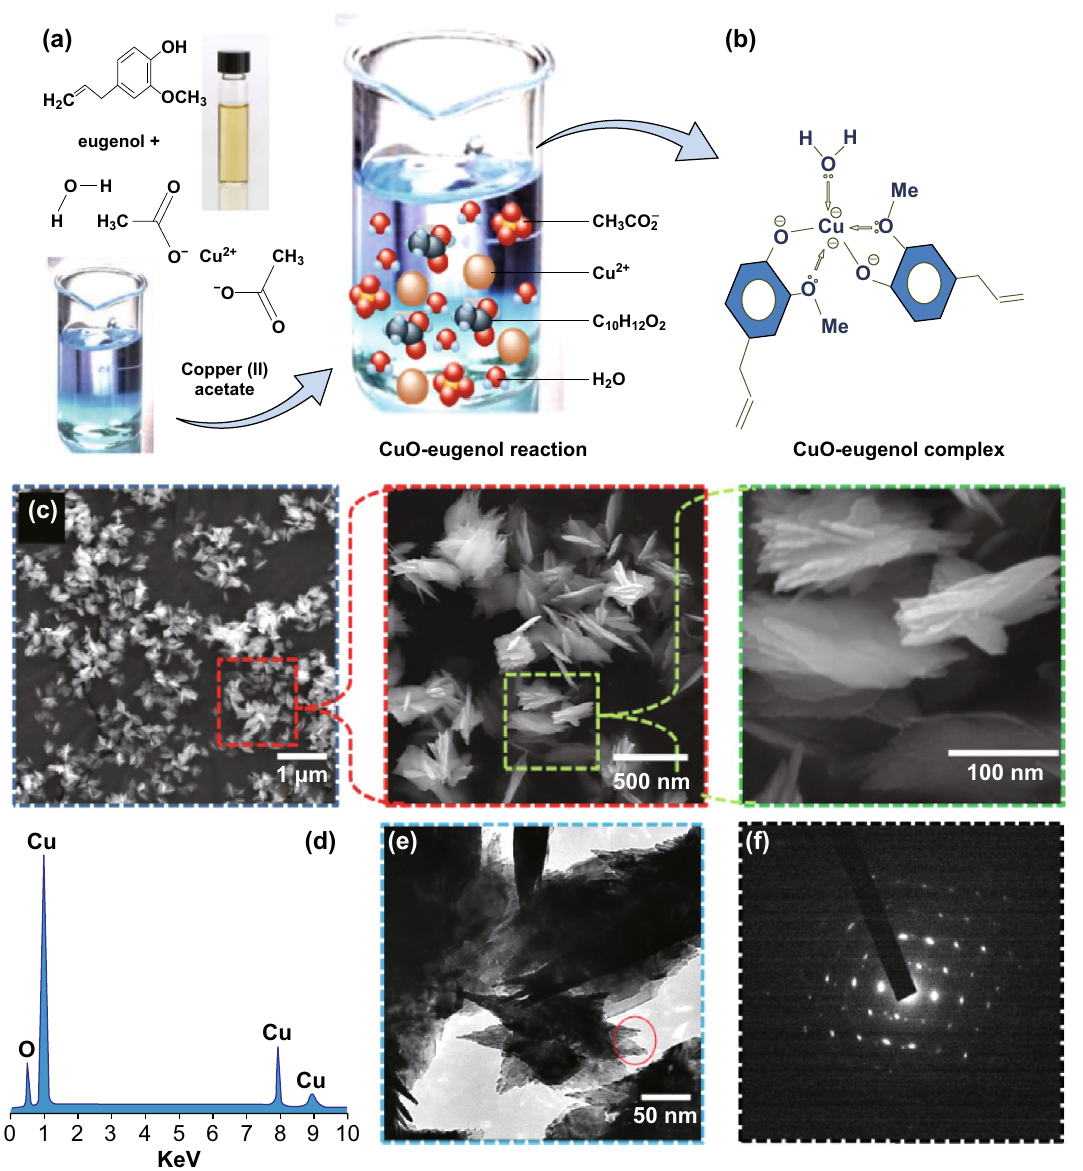
Fig. 1 a , b Tentative mechanism of crystal growth through copper–eugenol complex process. c FESEM images of eugenol-assisted CuO nano- flowers with different magnifications. d EDX spectrum. e TEM image, and f SAED pattern of eugenol-assisted CuO nanoflowers. (Color figure